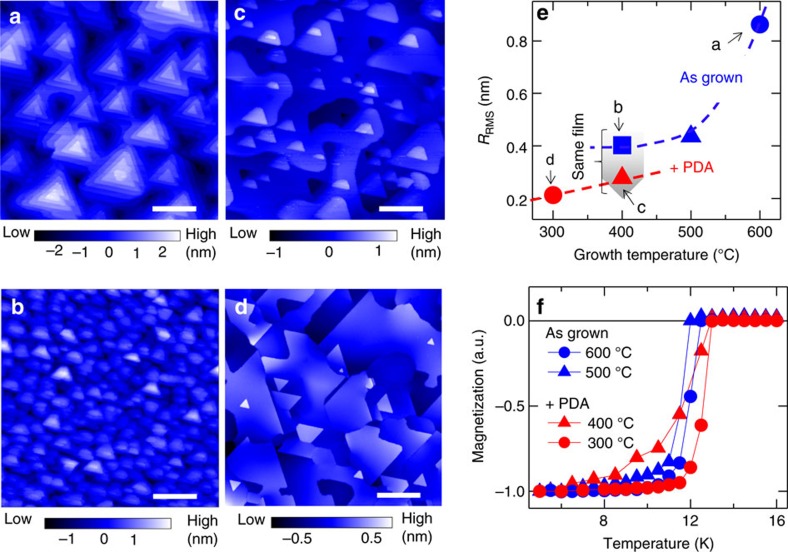
Surface topographies and superconducting critical temperatures.(a,b) STM topographic images of as-deposited thin film at substrate temperature of 600 °C (a) and 400 °C (b). (c,d) STM images after post-deposition annealing (PDA) for films deposited at 400 °C (c) and 300 °C (d). Note that b,c are taken with using the same film. a–c are obtained at 77 K and d is obtained at 4.2 K (all the STM images were observed at a sample-bias voltage of +300 mV and a tunnelling current is about 10 pA). Scale bar, 80 nm (a–d). (e) Growth temperature dependence of root mean square of surface roughness (RRMS) values: as-grown samples (blue symbols) and after PDA (red symbols). The value of RRMS is evaluated from topographic images observed at a sample-bias voltage of +300 mV and a tunnelling current of 10 pA (scan area of 400 nm). (f) Temperature dependence of the field-cooled dc magnetic susceptibility for the LiTi2O4 films in a magnetic field of 50 Oe, which was applied parallel to the (111) plane. Clear diamagnetism is observed.